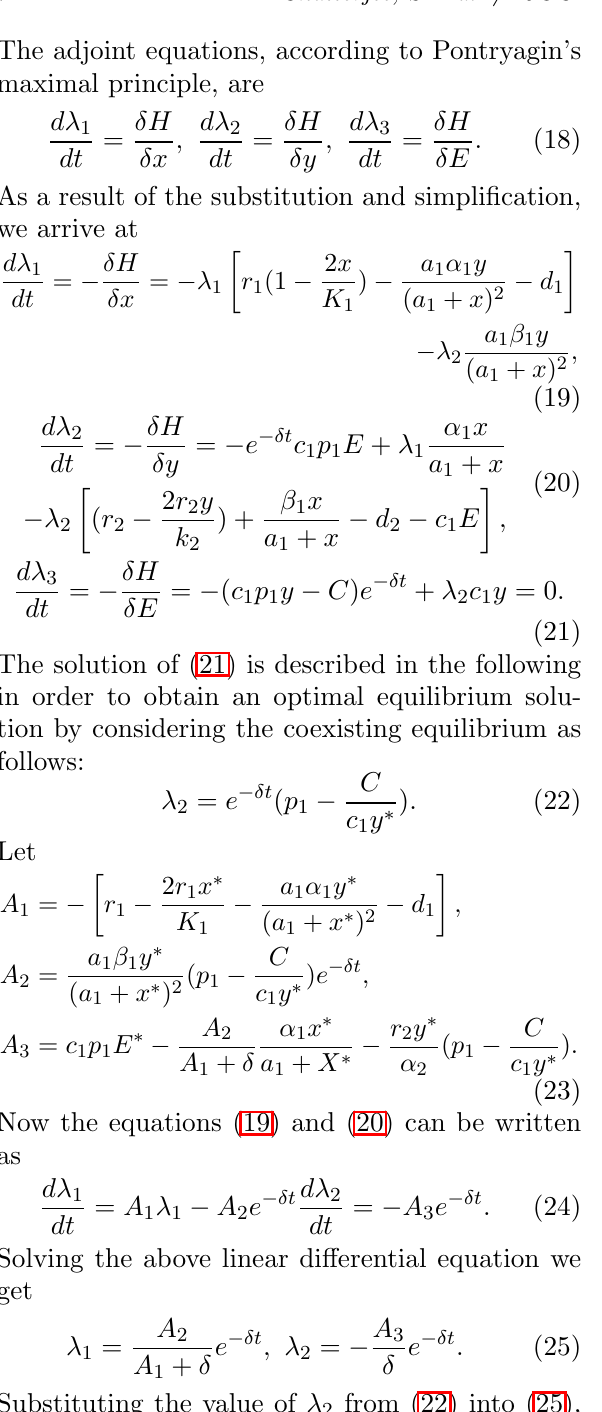
exhibits oscillation around S ∗ (cf. Figure 1a (red line)). In case of K 2 = 0 . 4, then Figure 1a (blue line) shows the system switches to harvesting ef- fort free equilibrium S 4 . tax per unit biomass of the predator, τ 1 = 0 . 52, ble. Increasing the value of τ 1 = 0 . 7, the sys- tem switches to prey free equilibrium S 2 in ab- sence of harvesting effort (cf. line)). It is observe that the system switches to stable to oscillatory behavior around S ∗ due to low value of r 2 = 0 . 2 (cf. Figure 1c). But in both case of r 1 = 1 and K 1 = 0 . 3 the system switches to prey free equilibrium simultaneously (cf. trate the different steady state behaviour of each species in the system (5) for the parameter τ 1